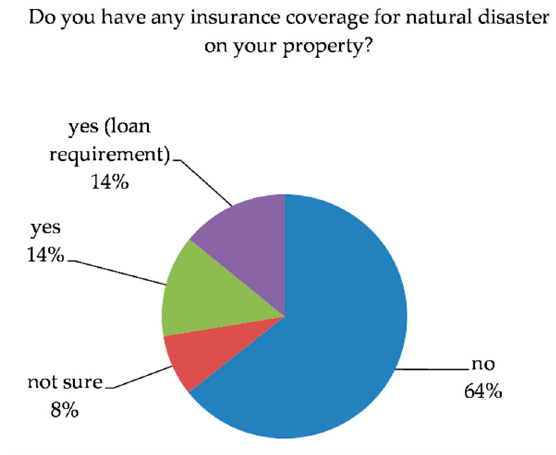
Figure 10. Distribution of answers with regard to the purchase of insurance.